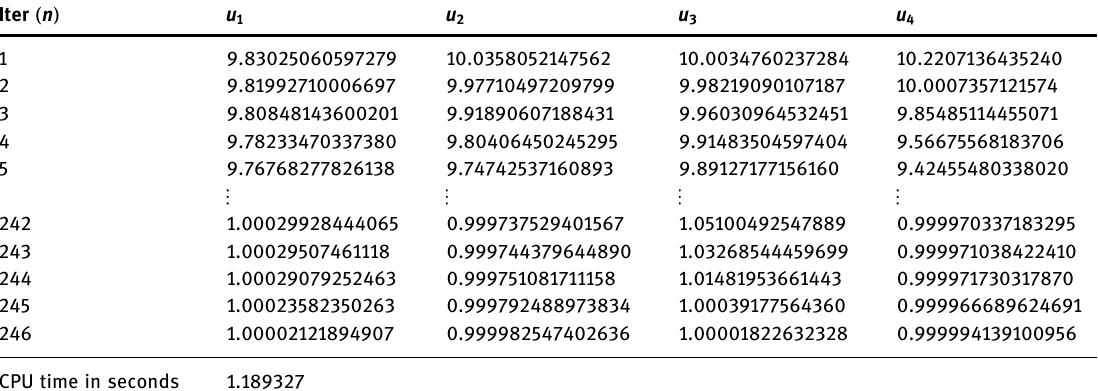
Table 6: Example 4.2: Numerical study of Algorithm 2 in [ 30 ]